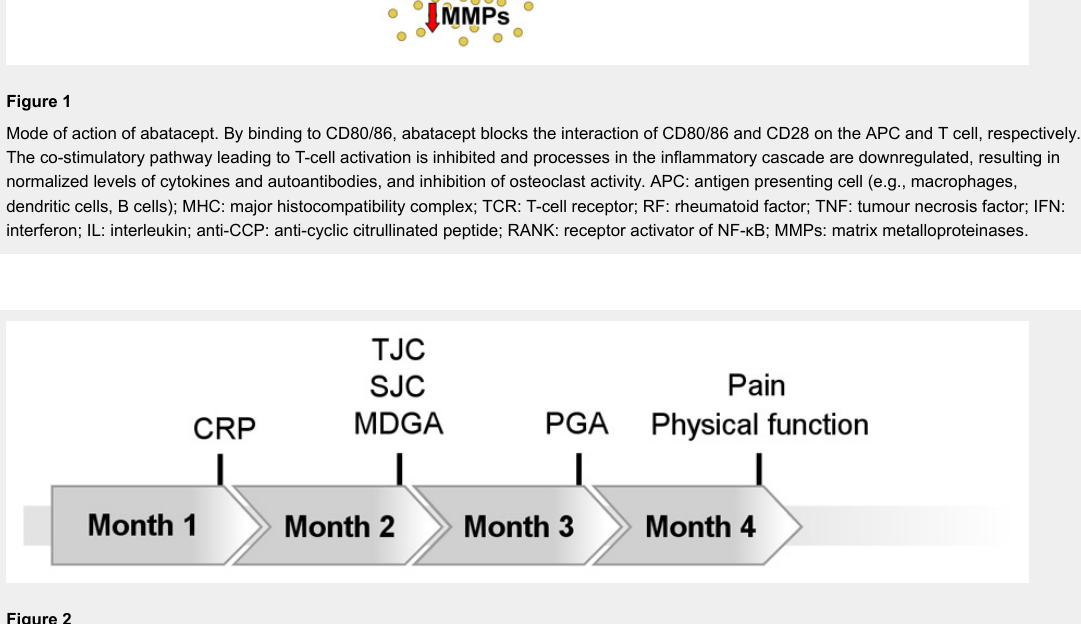
Figure 2 Median time to at least 50% improvement in individual ACR core components (LOCF). Figure based on data of the AGREE study as reported by Durez et al. [18]. CRP: C-reactive protein; TJC: tender joint count; SJC: swollen joint count; MDGA: physician’s global assessment; PGA: patient’s global